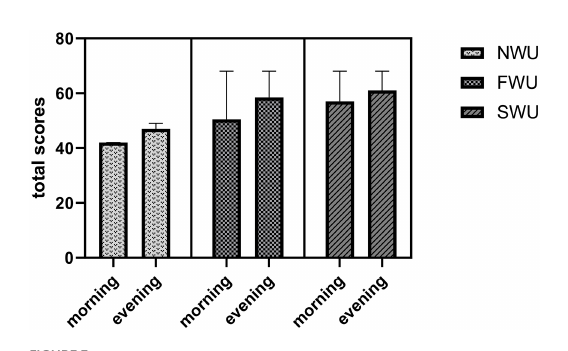
FIGURE 3 Uchi-komi Fitness Test (total scores) in the morning and evening hours for the three warm-up protocols. NWU, No-warm-up; SWU, Specific warm up; FWU, Linear and Lateral warm up.